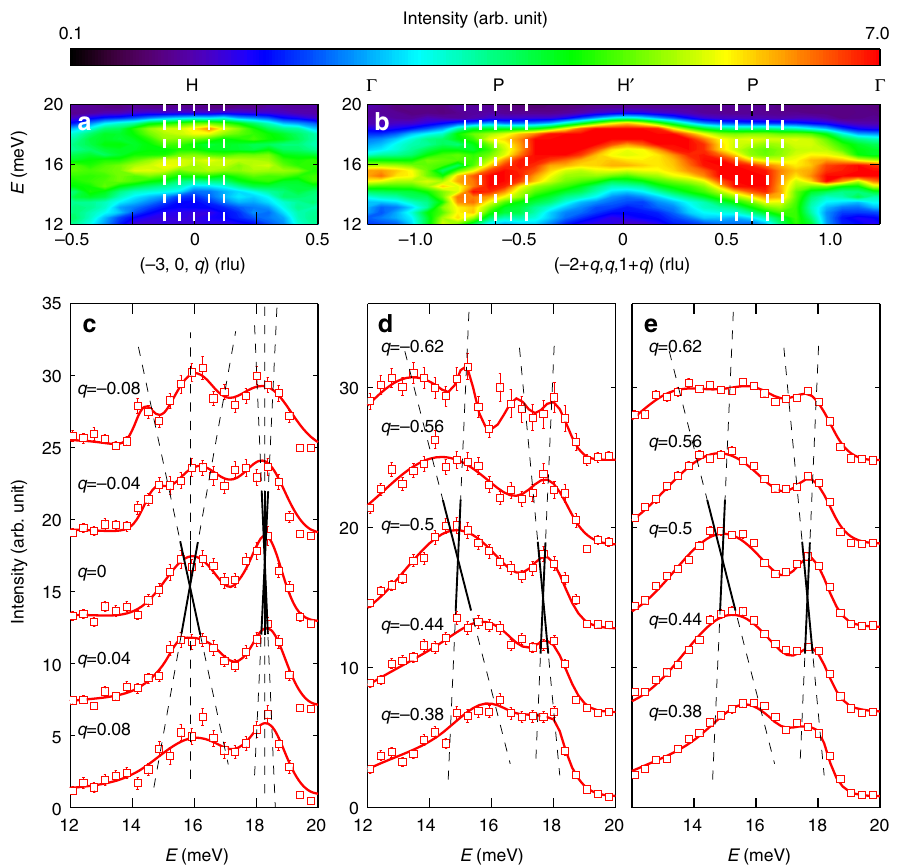
Fig. 4 Linear dispersions near triply degenerate and Dirac nodes. a Dispersions along the [001], and b [111] directions. c Constant- Q (wave vector) cuts indicated by the vertical dashed lines in a . Constant- Q cuts along negative and positive q s in b are plotted in d , e , respectively. The intensities of the cuts in c – e are offset to elaborate the dispersion. Red solid lines through data are fi ts with Gaussian functions. Black solid lines in c – e are guides to the eye illustrating the linearity of the dispersions, while dashed lines are their